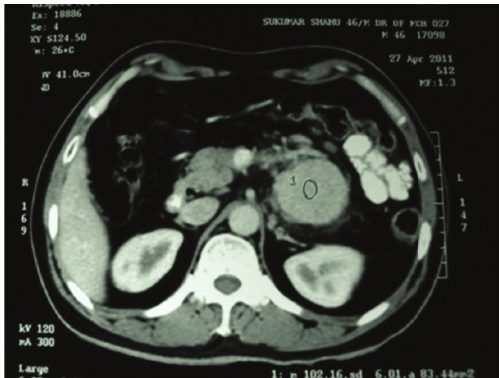
Figure 1: CECT showing homogenous mass in relation to the tail of the pancreas.